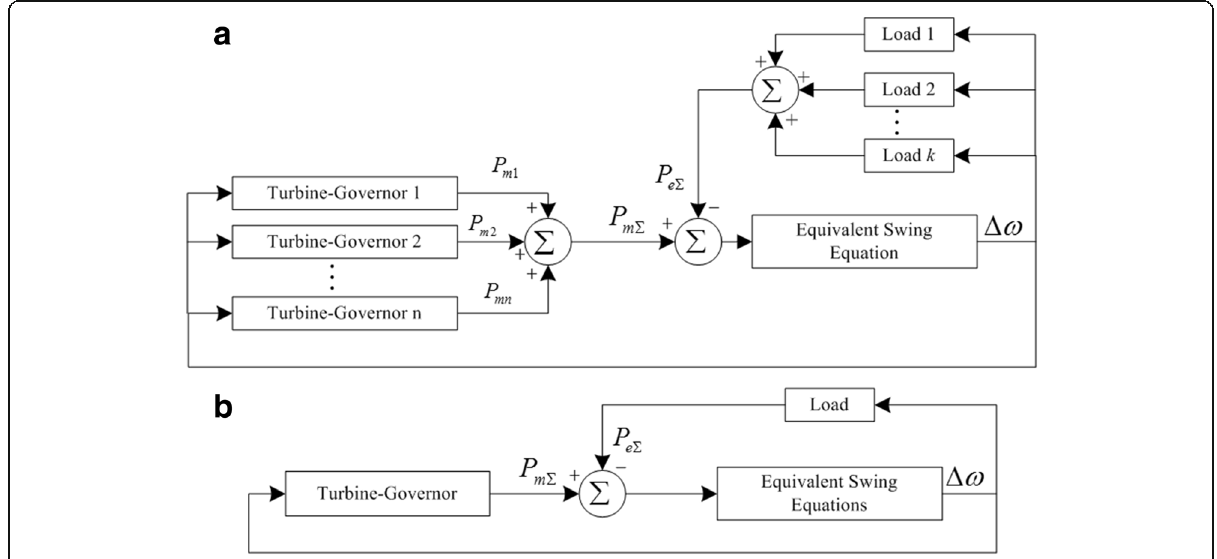
Fig. 2 Block diagram of ASF and single machine model. a General ASF model. b Single machine